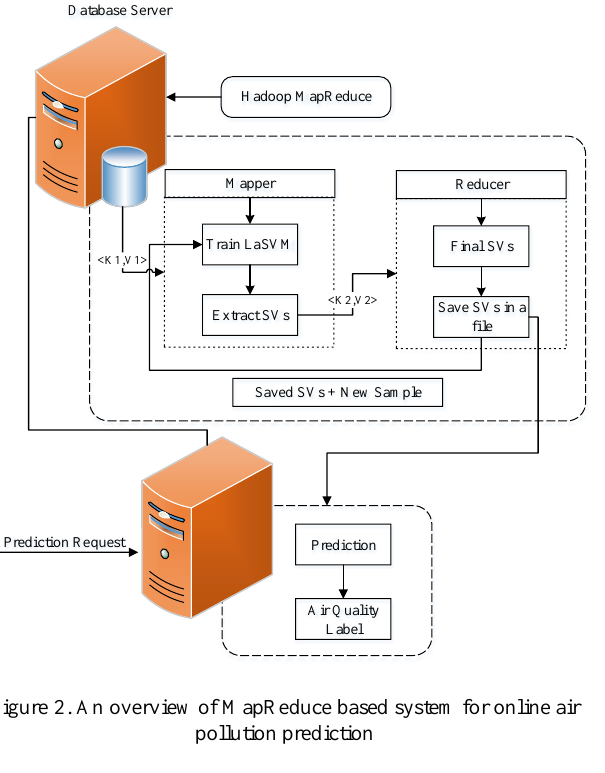
Figure 2. An overview of MapReduce based system for online air